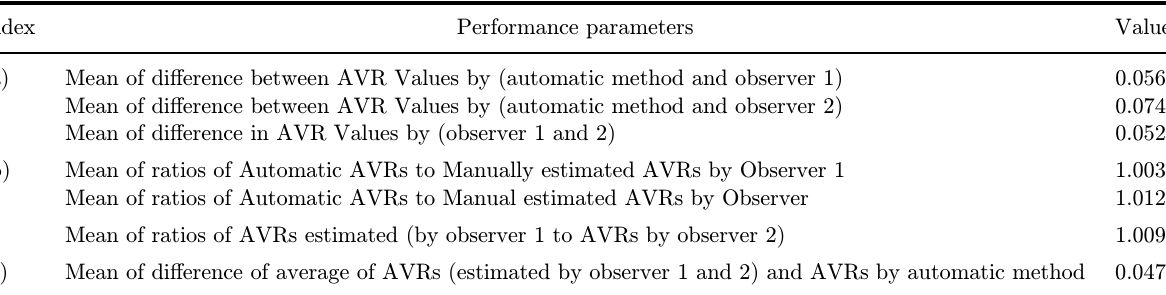
Table 8. AVR calculation results for INSPIRE-AVR database.